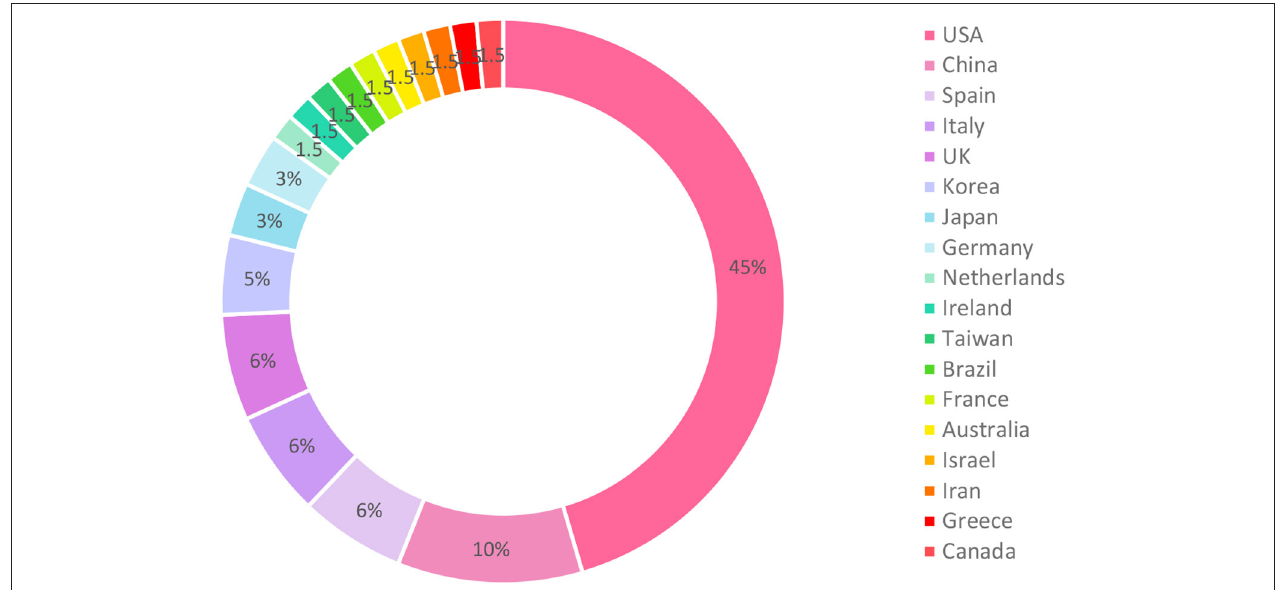
FIGURE 3 | Distribution of included studies in the countries.